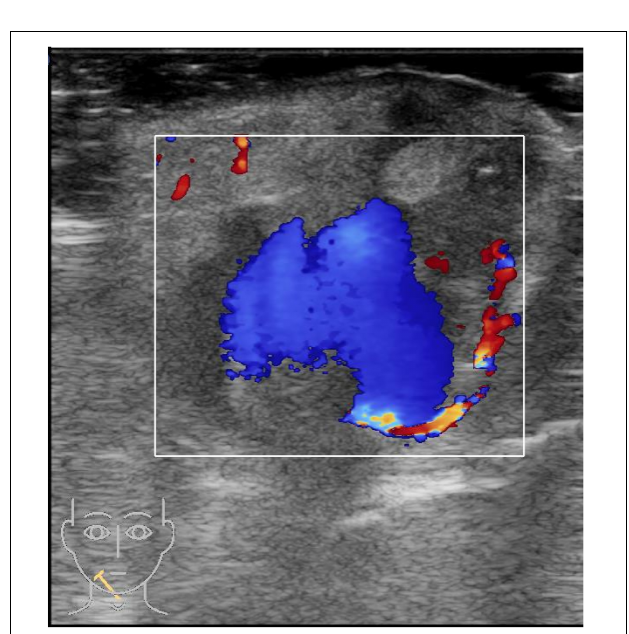
FIGURE 3 | A color Doppler ultrasound of the right cheek. The pseudoaneurysm is connected to a branch of the facial